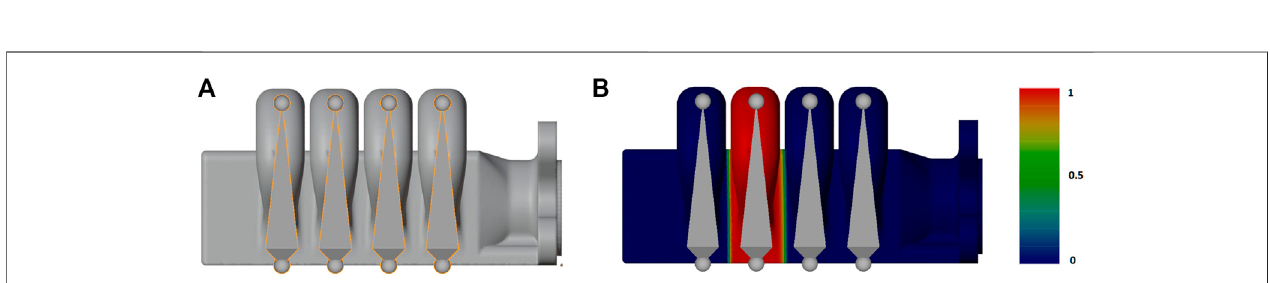
FIGURE 4 | Different Sampling visualizations of original CAD model, with decreasing mesh density per row. The original cad model was exported from SOLIDWORKS,andinBlender,itwassampledatdifferentdensities[ (A) 847 kverts,1.7 Mtris; (B) 82 kverts,164 Ktris; (C) 13 kverts,26 ktris;and (D) 3.2 kverts,6 k tris], after which the decimation/remeshing algorithms which simpli fi ed the mesh topology.